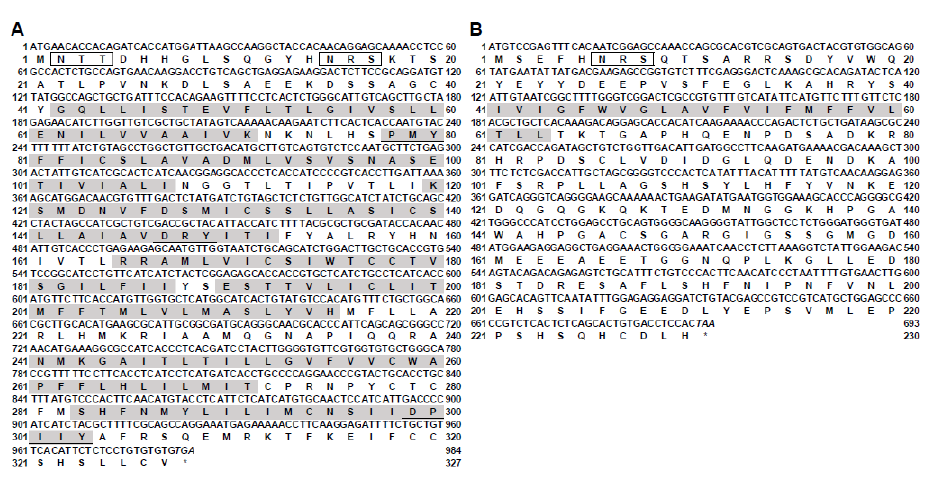
Figure 1. Nucleotide and deduced protein sequences of snakehead MC4R ( A ) and MRAP2 ( B ). Positions of nucleotide and amino acid sequences were indicated on both sides. Open boxes denoted the consensus sequence for N-linked glycosylation sites. Amino acids in shaded boxes indicated putative transmembrane domains. Underlines showed PMY, DRY, and DPxxY motifs in MC4R. Asterisk (*) indicated stop